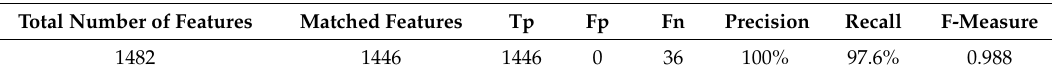
Table 3. Benchmark results obtained by matching LC-full scan HRMS data of a wheat sample (serving as a target file) to a list of MetExtract-derived features from the same datafile (serving as the reference list).